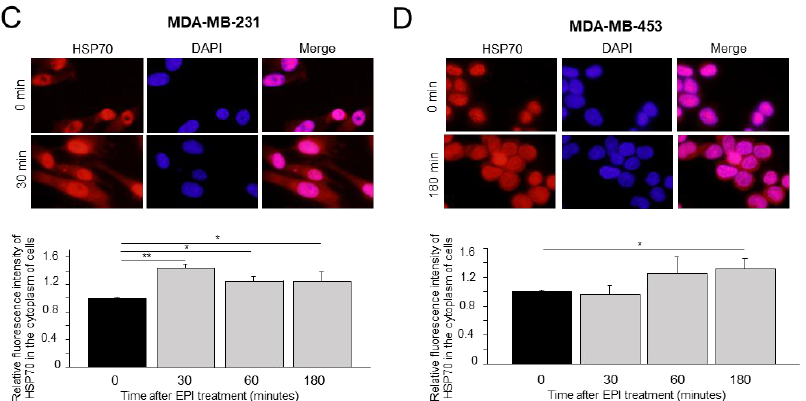
Figure 2. Expression of heat shock protein (HSP) 70 in breast cancer cells after chemotherapy. ( A , B ): HSP70 protein level in the CM ( A ) and small extracellular vesicles (sEVs) ( B ) from MDA-MB-231 and MDA-MB-453 cells treated with EPI for 24 h (CM) or 96 h (sEVs). CD63 was used as the sEV marker. ( C , D ): Fluorescence immunocytochemistry for HSP70 (red) in MDA-MB-231 ( C ) and MDA- MB-453 ( D ) cells treated with EPI (10 μM). The cytoplasmic HSP70 fluorescence intensity of 40 cells per well was measured using ImageJ software at 40× objective magnification. The average scores were calculated and presented as the fold change (mean ± S.D., n = 3). * p < 0.05, ** p < 0.01 vs. control (0 min). BC: breast cancer, CM: conditioned medium, EPI: epirubicin, sEVs: extracellular vesicles. The uncropped blots are shown in Supplementary Materials.